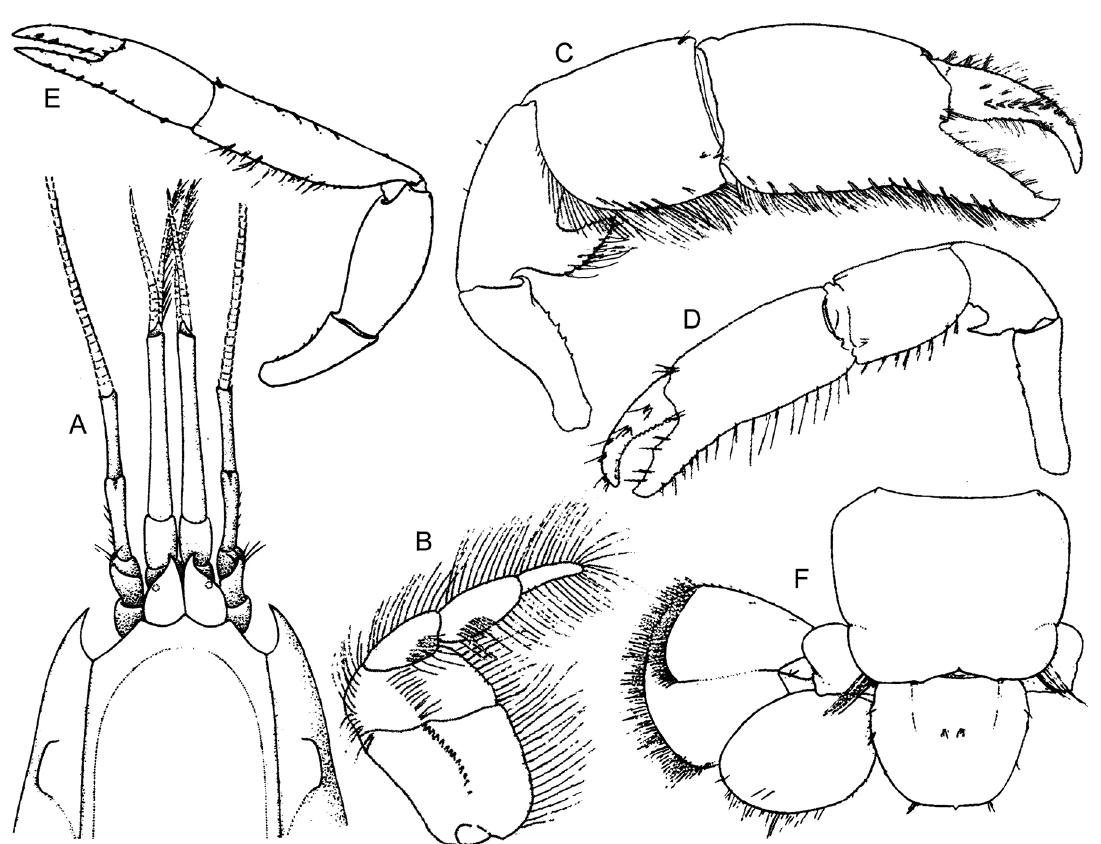
Figure 1. Gilvossius setimanus s.s ., adapted from Williams (1984: fig. 125a–d), male, USNM 14096 ( A , C , E , F ) and from Rabalais et al. (1981: fig. 2b, c) female, USNM 51007 (B, D). A , anterior carapace, eyes, antennules, and antennae, dorsal surfaces; B , third maxilliped, internal surface; C , D , major cheliped, external surface; E , minor cheliped, external surface; F , sixth pleonal somite, telson, and left uropods, dorsal surfaces. Not shown to